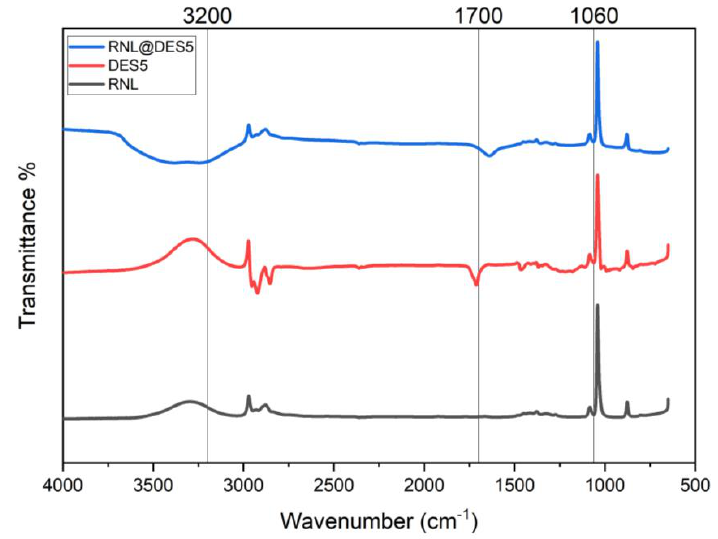
Figure 10. FTIR stacking spectra expressed as a percentage of free lipase (%T), DES5, and RNL@DES-5 after incubation at the following conditions: lipase concentration: 1 mg mL −1 , 2 h, 300 rpm, pH 7.00, and 40 °C. Table 5. FTIR spectra of key functional groups and their correspondence wavenumber (cm −1 ) of free lipase, DES5, and RNL@DES-5.